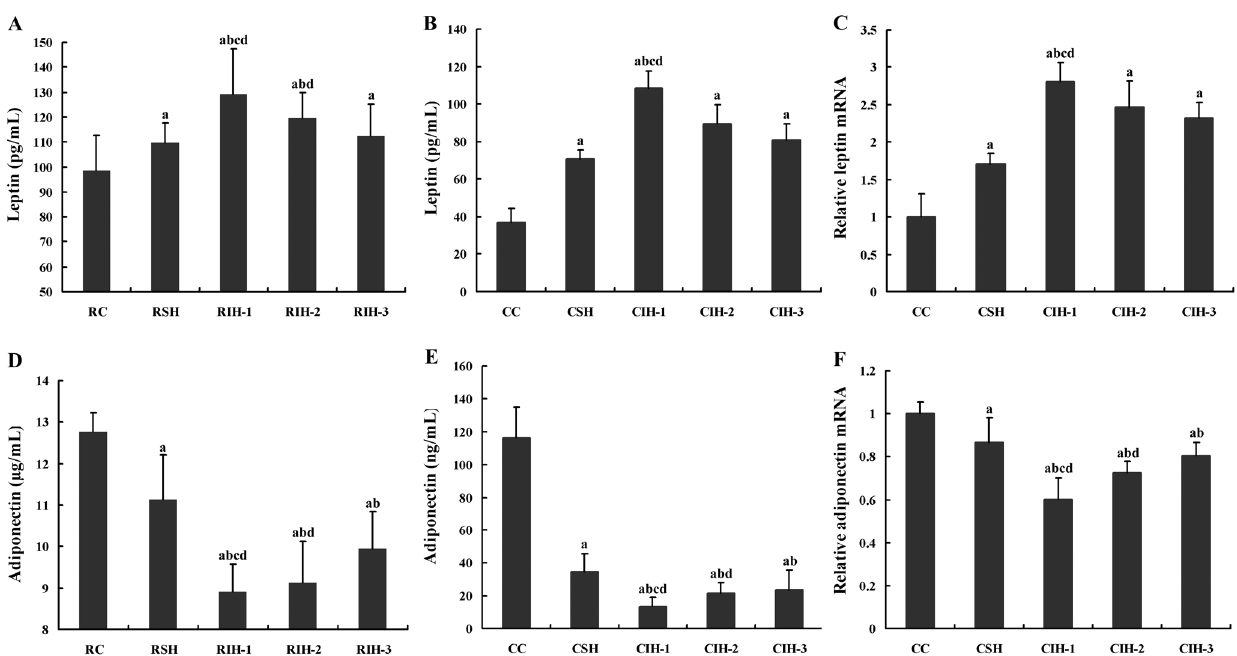
Figure 5. Effects of IH on mRNA and protein levels of Leptin and Adiponectin. a P , 0.05 compared with RC or CC group; b P , 0.05 compared with RCH or CSH; c P , 0.05 compared with RIH-2 or CIH-2,. d P , 0.05 compared with RIH-3 or CIH-3.